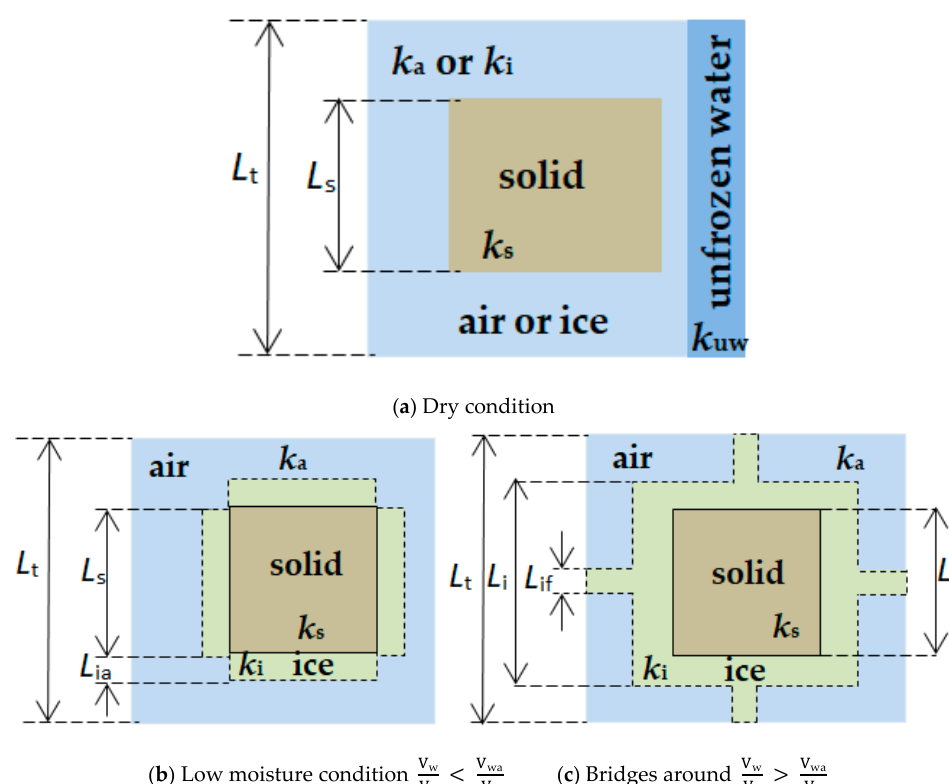
Figure 6. Representation of the saturated soils, ( a ), and the unsaturated soils, ( b ) and ( c ).